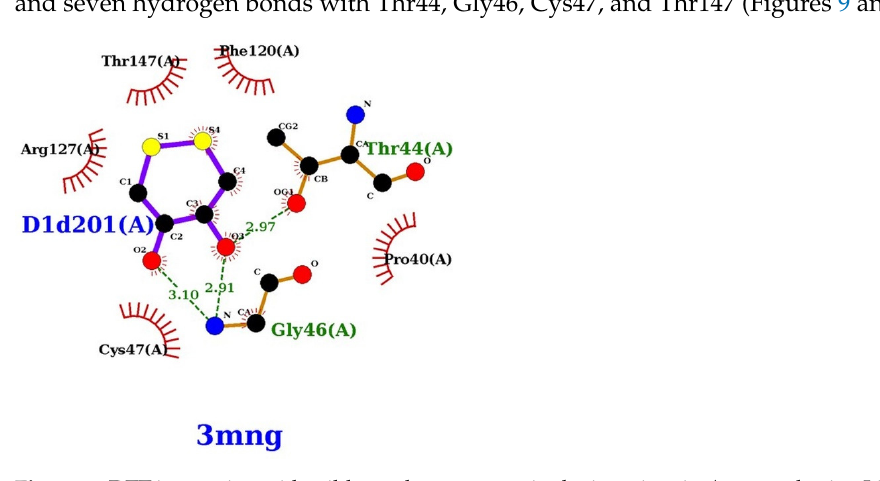
Figure 9. DTT interaction with wild-type human peroxiredoxin active site (prepared using LigPlot+ [60]).